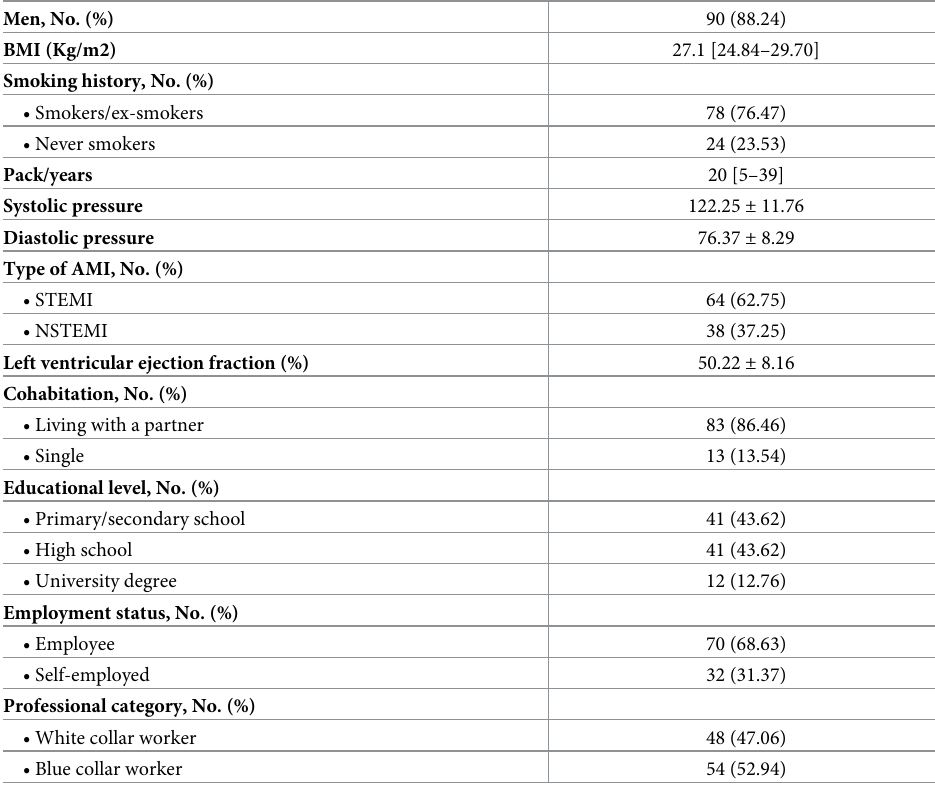
Table 1. Baseline characteristics of study patients. Men, No.